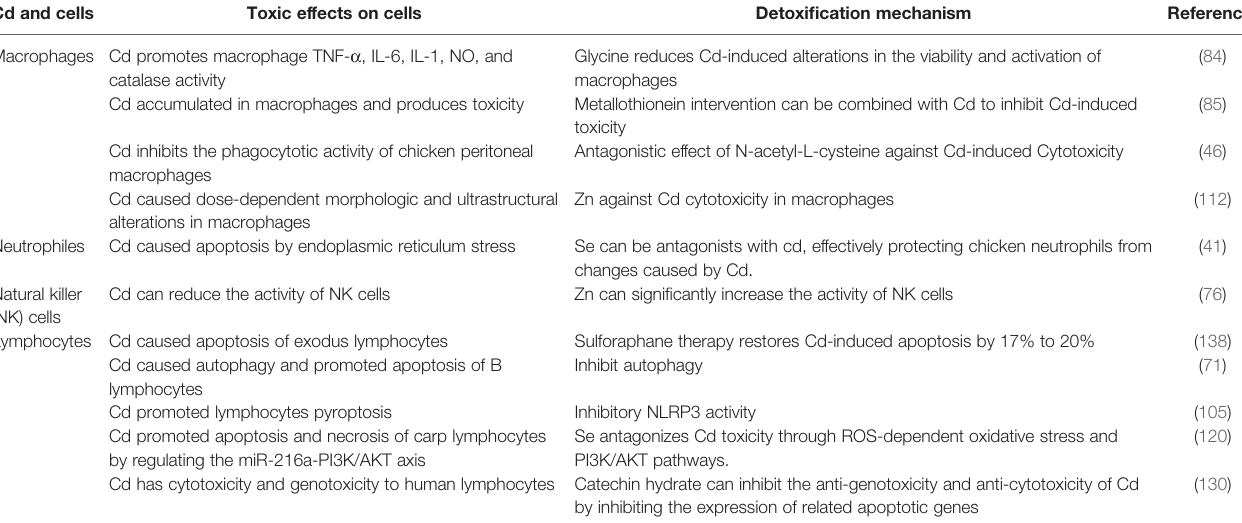
TABLE 3 | The detoxi fi cation mechanism to inhibit Cd immunotoxicity. Cd and